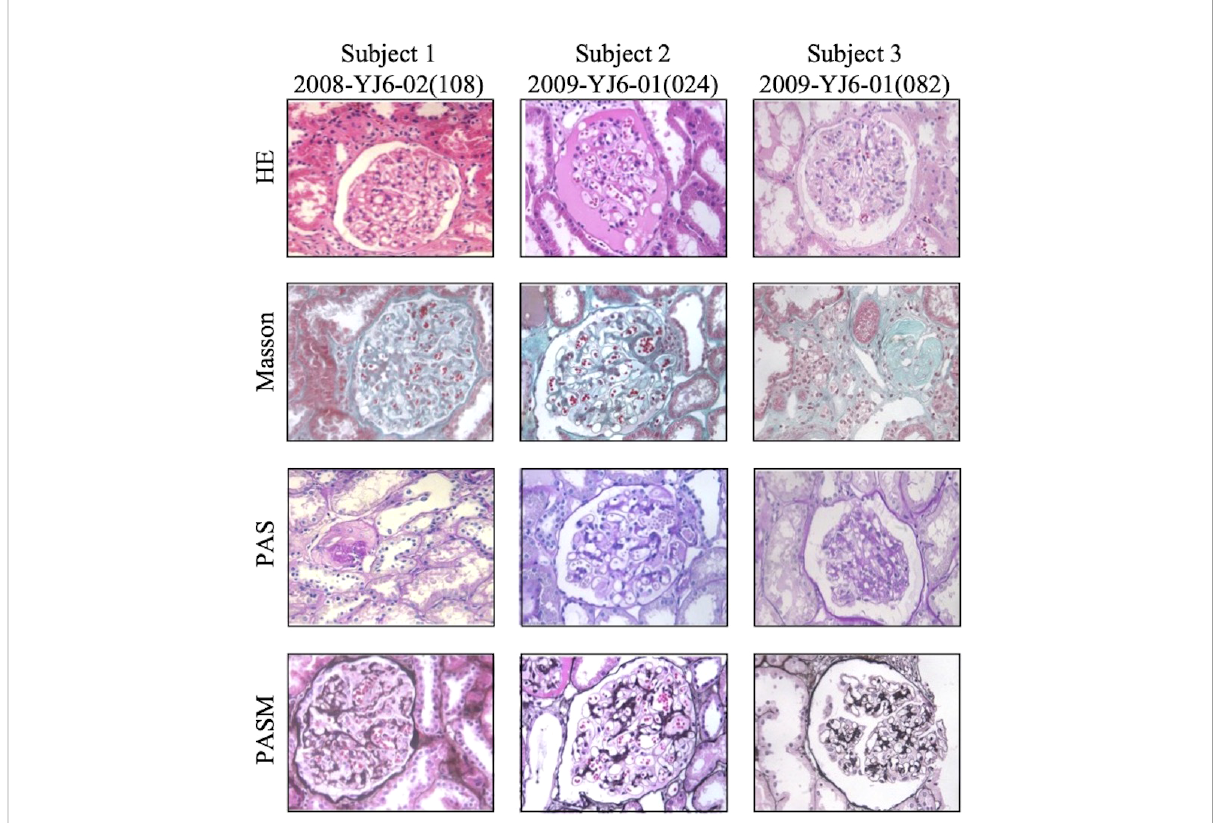
FIGURE 4 Representative pictures of tbe latest kidney allograft biopsy staining of three subjects. Tbe time of biopsy after KT above for subject I, subject 2 and subject 3 was 6 years, 5 years and 12 years, respectively. No signs of rejection was recognized. Pictures were taken at 400x magni fi cation.